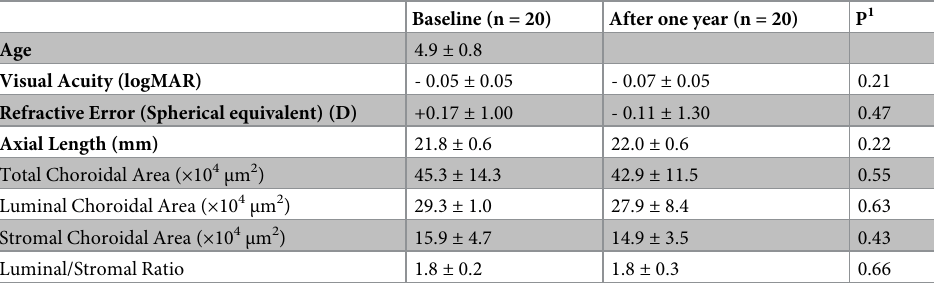
Table 5. Data of the controls of the baseline and after one year.